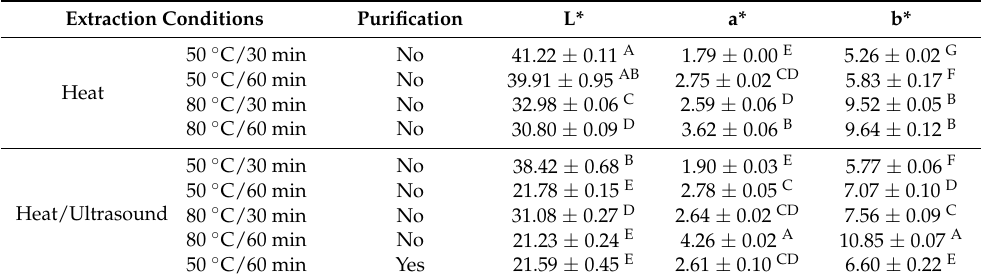
Table 2. The color of chia seed mucilage powders extracted with different combinations of ultrasound and heat. Extraction